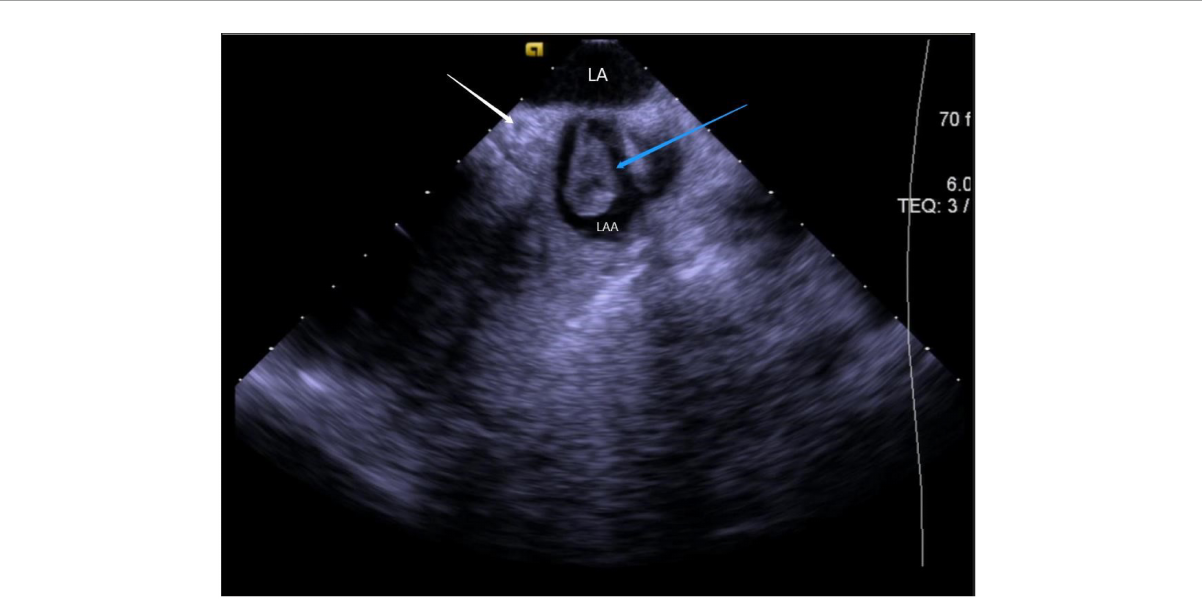
FIGURE12 Still frame of formation of thrombus under ICE. LA, left atrial; LAA, left atrial appendage; Blue arrow, thrombus in the left atrial appendage; White arrow, LCX (left circumflex artery).